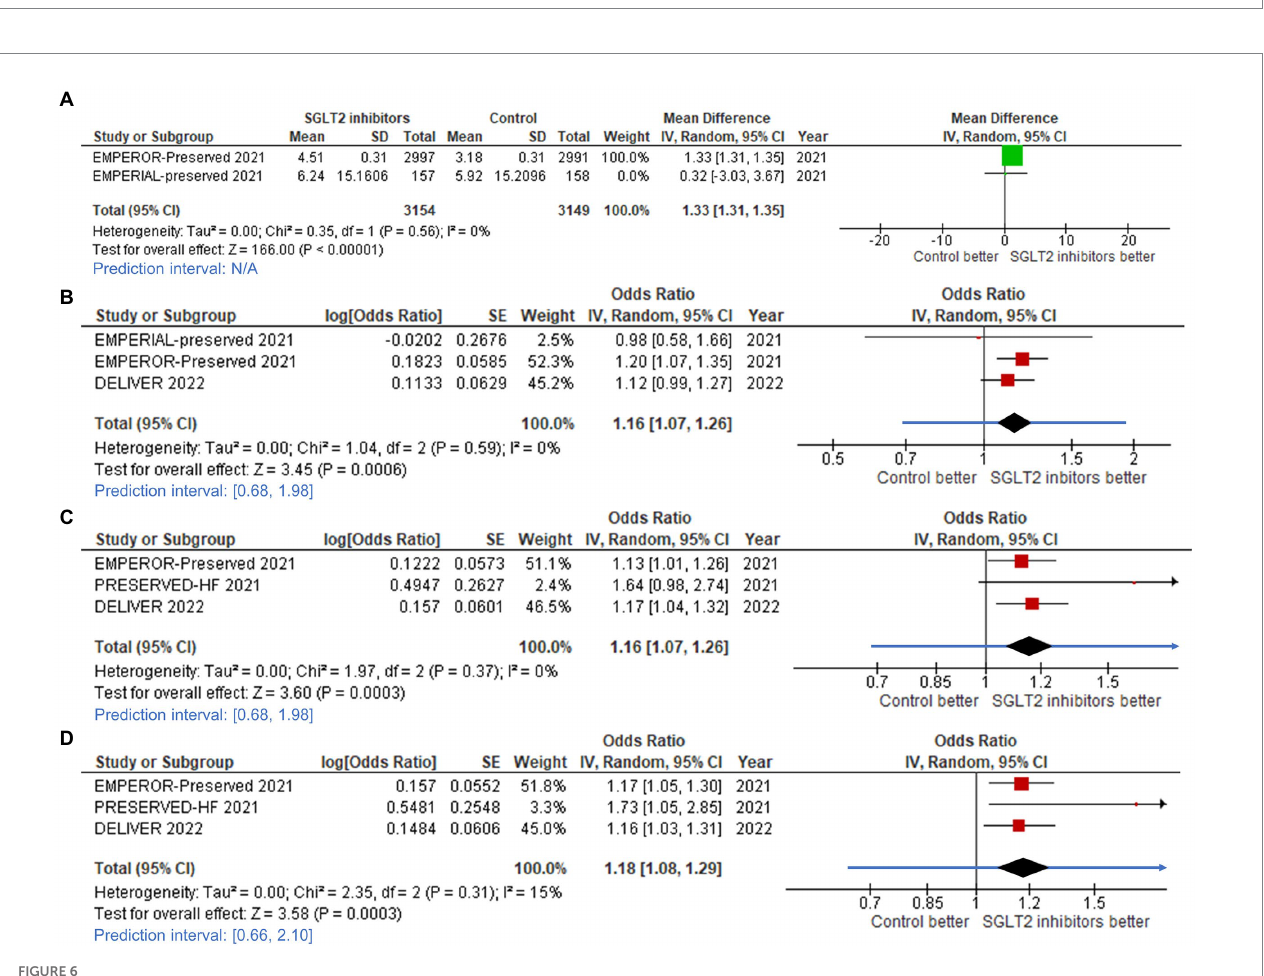
FIGURE 6 Forest plots of studies that evaluated (A) change in Kansas City Cardiomyopathy Questionnaire (KCCQ) – clinical summary score; (B) increased KCCQ-total symptom (TS) score; (C) increased KCCQ-clinical summary (CS) score; and, (D) increased KCCQ-overall summary (OS) score compared between patients receiving sodium-glucose cotransporter-2 (SGLT2) inhibitors and controls among all heart failure with mildly reduced (HFmrEF) or preserved ejection fraction (HFpEF)